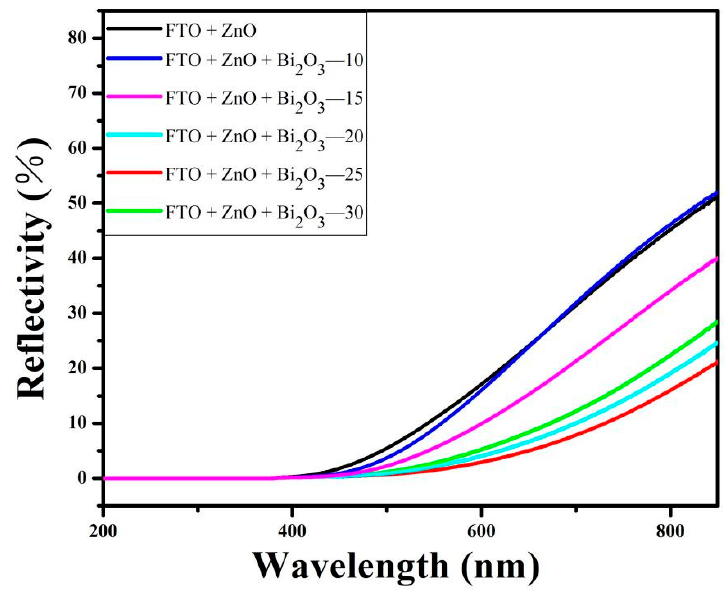
Figure 4. UV-Visible reflectance spectrum of the